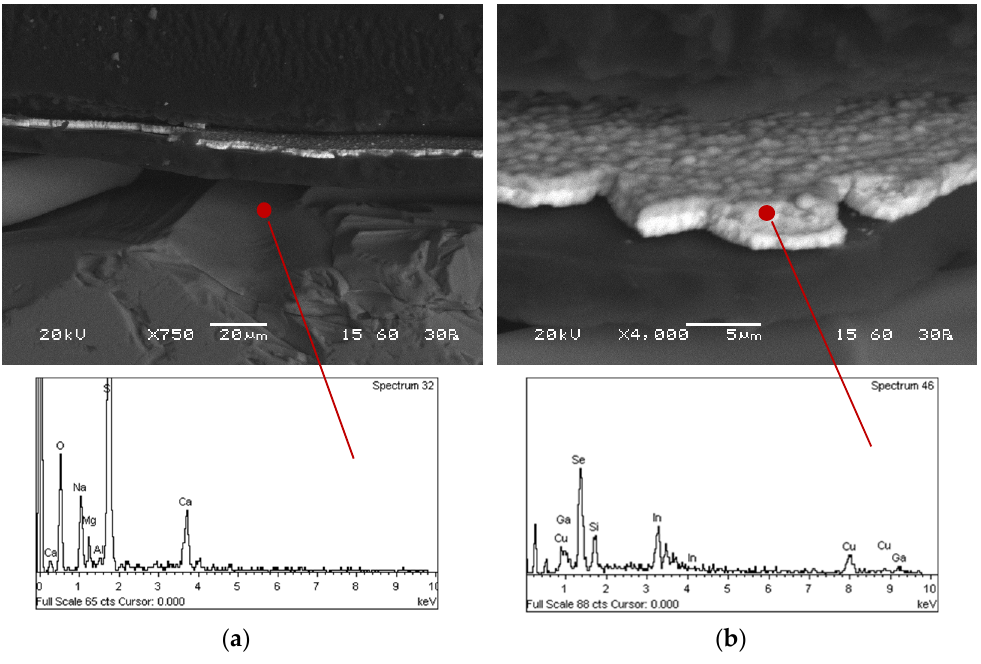
Figure 2. Internal structure of the thin film photovoltaic panel: ( a ) glass and ( b ) thin film.